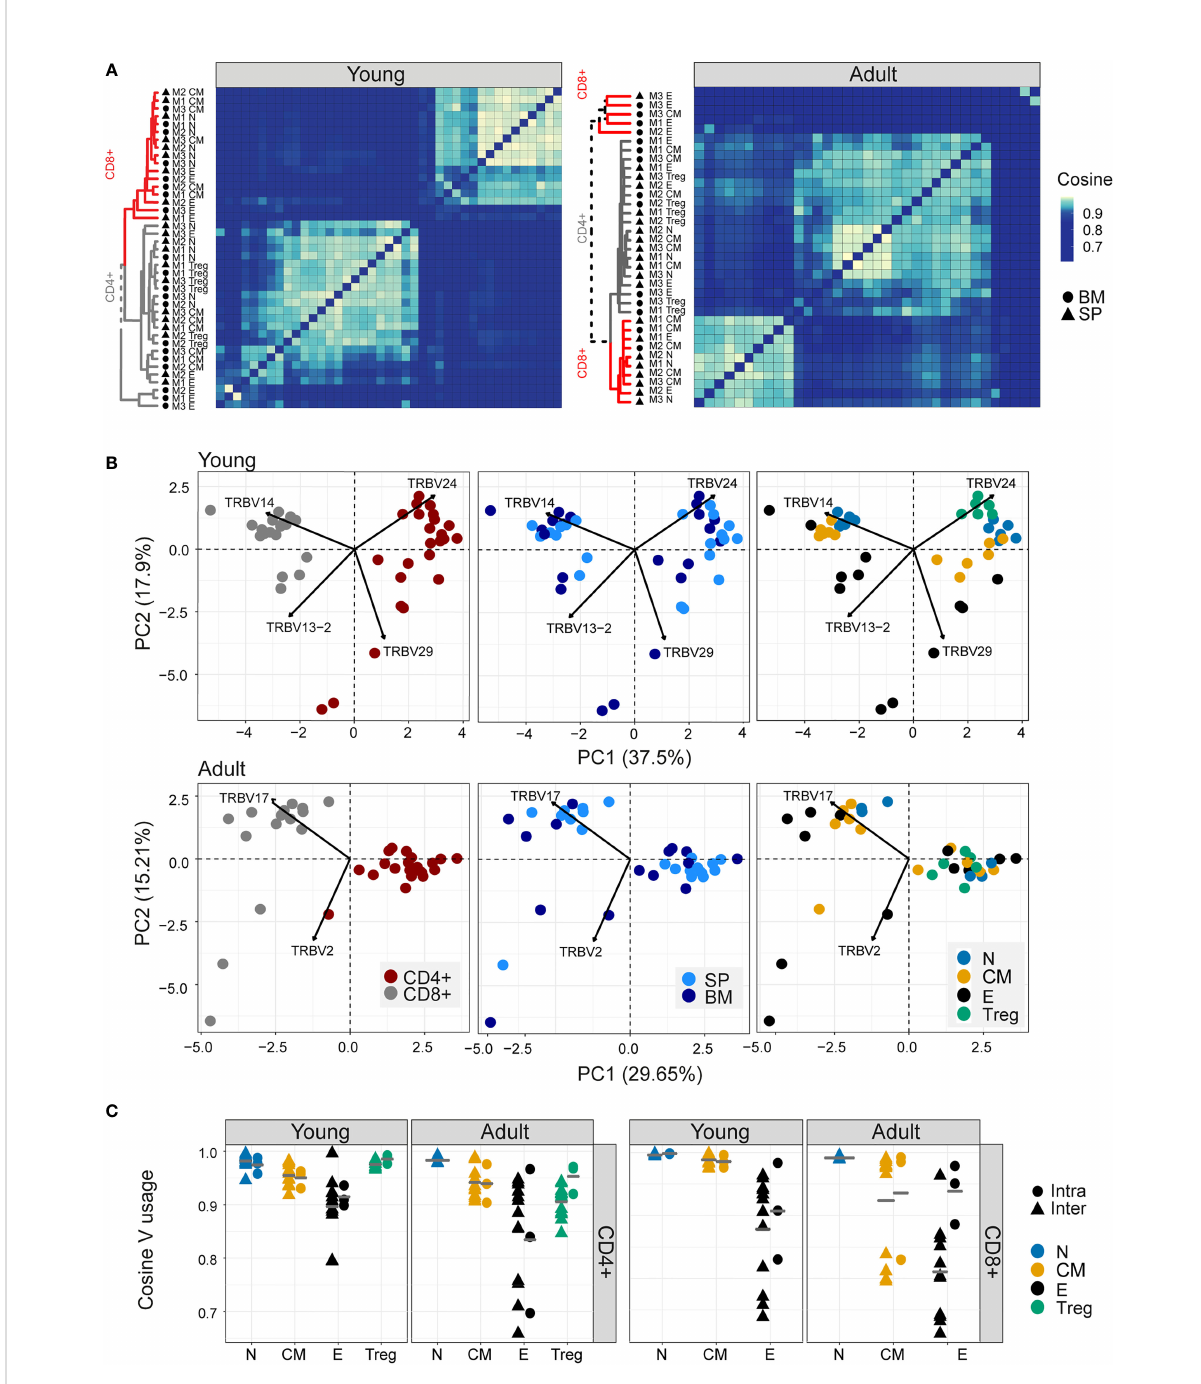
FIGURE 2 Different sub-populations of T cells in young individuals have different V gene distributions. (A) Cosine similarity was calculated between the V gene distributions for all pairs of repertories in young (left) or adult (right) mice and displayed as a heatmap. Hierarchical clustering dendrograms show the assigned organization at each plot, colored by CD4+ and CD8+ groups (grey and red branches respectively) and labels by compartment (text and symbol). Tissues are marked in symbols shape (SP = triangles, BM = circles). (B) PCA of the V b usage of CD4+ and CD8+ compartments in young (upper) and adult (lower) panels. Each color represents one compartment from one mouse (e.g., CD8+ Effectors, BM, mouse 1). See legend for symbols and color code. The V b genes with the highest in fl uence (loading) are marked with arrows. (C) Cosine similarity between V b gene usage distributions between individuals (circles) or within individuals (between spleen and bone marrow, triangles). The inter-individual variability was calculated separately for spleen and bone-marrow. Each point is the cosine value calculated between two different mice and tissues (SP-SP, SP-BM, BM-BM). T cells compartments (colored dots) are divided into CD4+ (left) and CD8+ (right) from young or adult mice. Mean is shown by horizontal grey